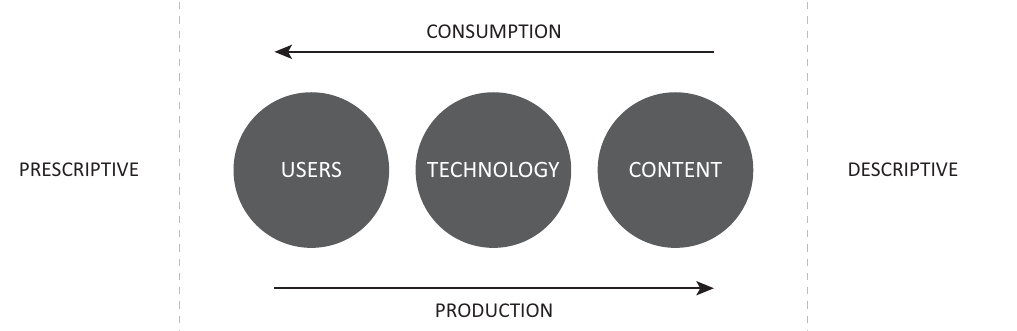
Figure 4. A model of contemporary digital literacy (digital literacies) research. Media and Communication, 2019, Volume 7, Issue 2, Pages